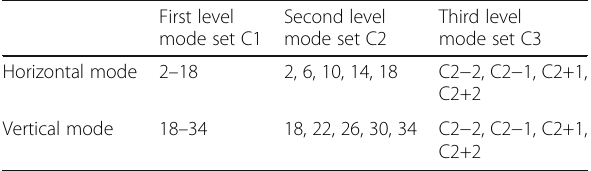
Table 3 Horizontal and vertical candidate modes for each level